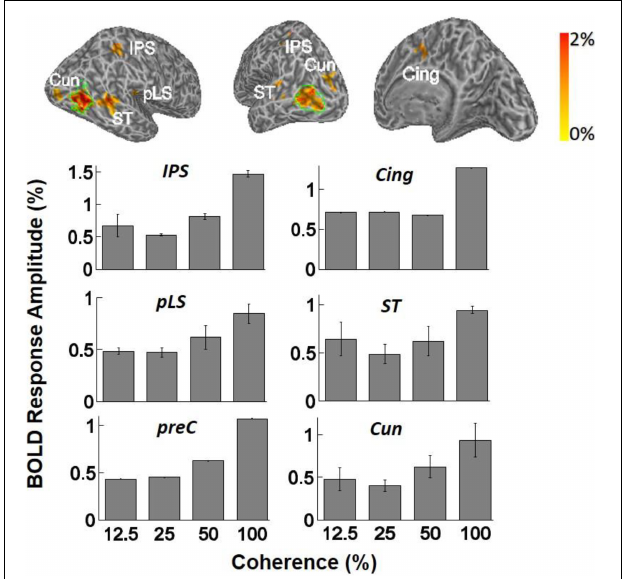
FIGURE 5 | Top: Examples of inflated white matter surfaces of individual subjects. Overlaid color maps represent the mean response amplitude across coherence levels of 25, 50, and 100% and show only the region with corrected p -values less than 0.05 in the GLM analysis. The green contours delineate the boundaries of area hV5/MT+ as determined from the hV5/MT+ localizer scans. Labels denote the anatomical locations of activated areas: ST, superior temporal sulcus; pLS, posterior lateral sulcus; Cun, cuneus; IPS, intraparietal sulcus; Cing, cingulate cortex; PreC, precentral sulcus. Bottom: Averaged fMRI response amplitudes in the activated brain areas (ST, IPS, Cing, PreC, pLS, and Cun) across subjects. The mean BOLD magnitude increases significantly as a function of motion coherence. Only subjects that showed significant activation in these areas when we contrasted all-coherent RDKs against the baseline are averaged (see section “Results for a Discussion”). Note that the analysis used the corrected-for-multiple-comparisons p -values for identifying which voxels were activated and then simply reported the responses inside the areas where the activation occurred. We did not intend to compare the level of activity across these areas. In any event, this should be considered as an exploratory study, identifying coherence modulated areas for further study in the